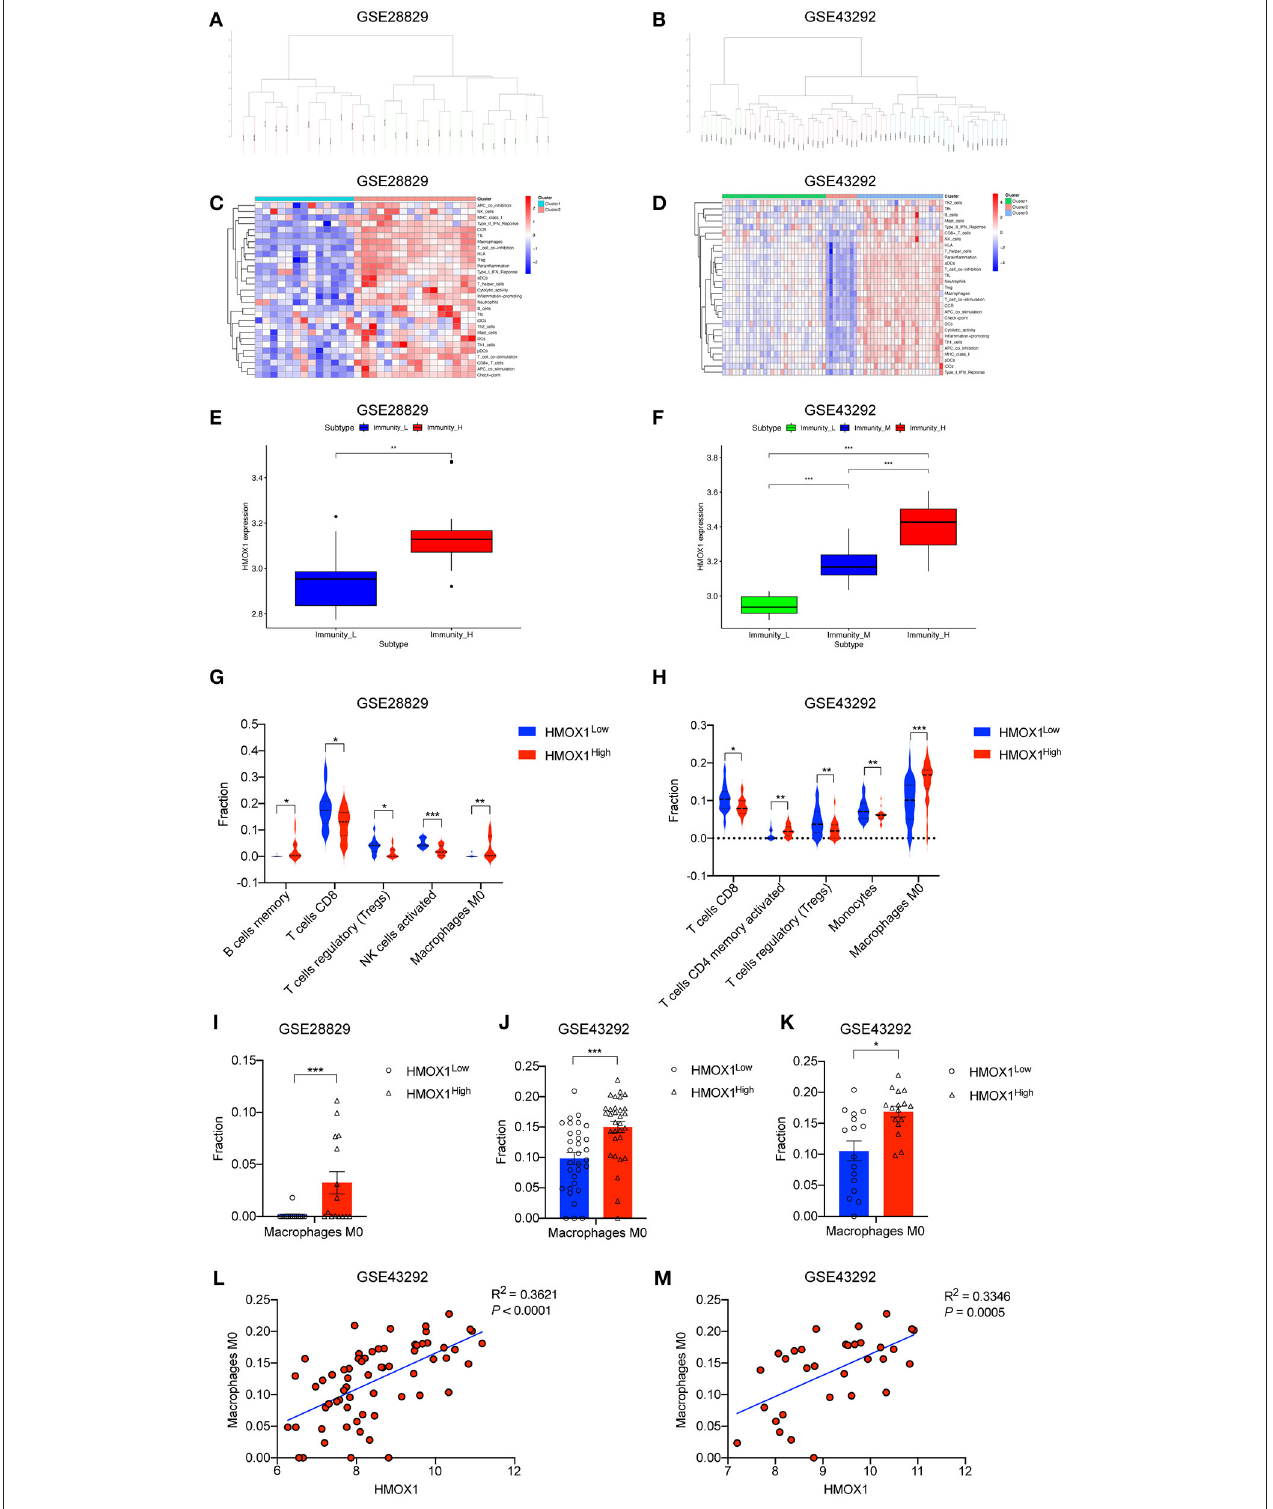
FIGURE 8 | ssGSEA analysis showing high-expression of HMOX1 was related to a stronger immune response and macrophage infiltration. Samples in GSE28829 and GSE43292 clustering by immune scores (A,B) . Heatmaps of different immune subtypes based on ssGSEA scores for 29 immune gene sets (C,D) .